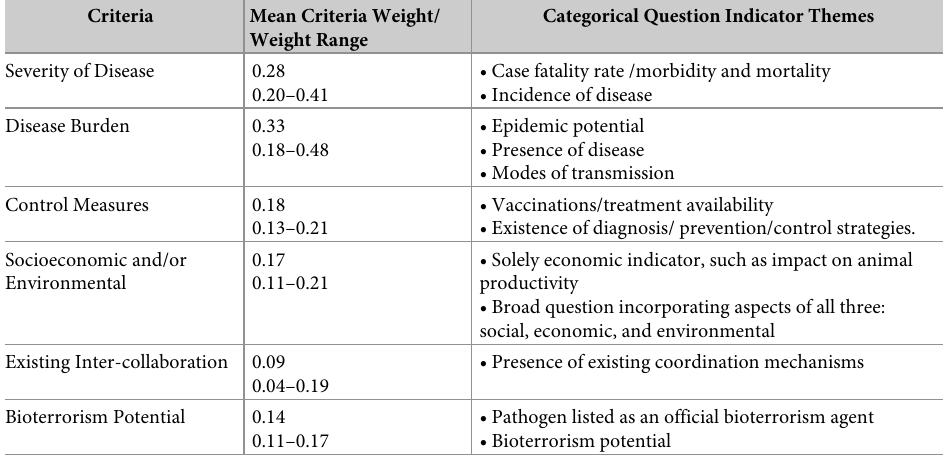
Table 1. Thematic and descriptive analyses results of past OHZDP